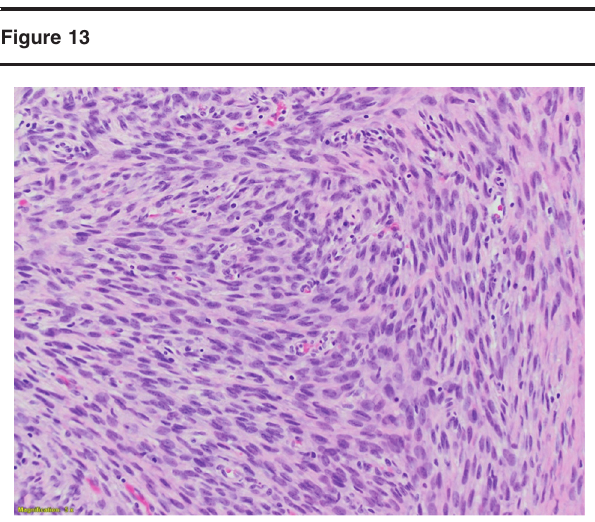
Endoscopic picture 2 months postoperatively. MT (middle turbinate), PC (posterior choana).